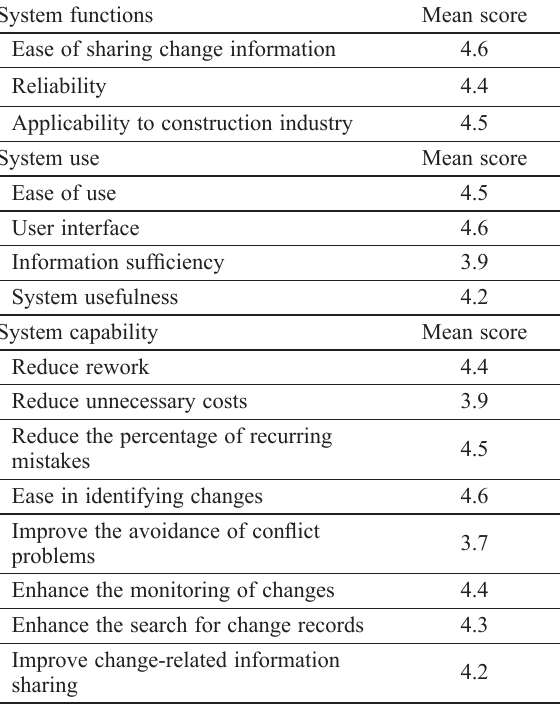
Table 4. System evaluation results